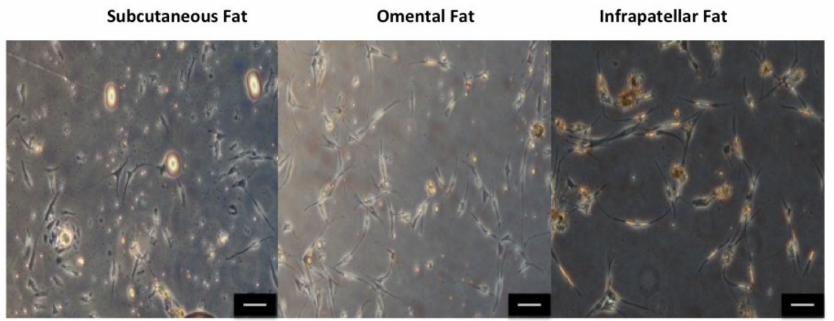
Figure 1. Phenotype of isolated adipose-derived stem cells (ASCs) from subcutaneous fat, omental fat and infrapatellar fat at P0. All cells show typical mesenchymal stem cell fibroblastic phenotype. No apparent difference in phenotype of isolated ASCs from three different sources of fat is detected. The scale bar represents 100 µ m. Results are from a representative of three independent experiments.